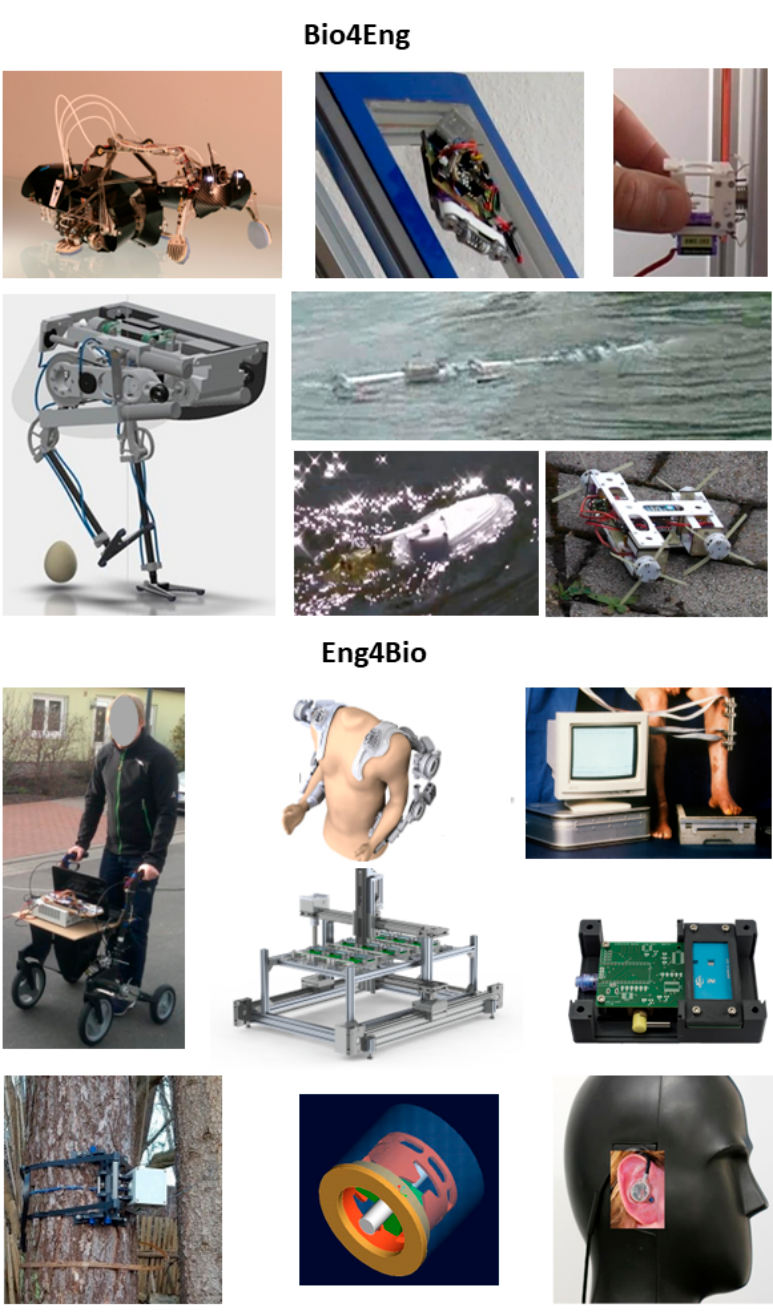
Figure 2. Examples of biomechatronic development. In reading order, please find for Bio4Eng the climbing robot RatNic (coop. Tetra GmbH lmenau, granted by the German Ministery of Education and Research BMBF) [60]; the window-cleaning robot MatBo t; the adhesive gripper TaCare ; the bird-like robot eNandu (coop. FSU Jena, Gentle Robotics); the swimming robots CSnake and Urmele ; the small wheg robot T-Whex . For Eng4Bio: the walker eRolli ; the modular exoskeleton Leviaktor (coop. FSU Jena, HS Aalen, Gottinger, BM innovations, LSK, granted by German Ministery of Education and Research BMBF), the figure is provided by Gottinger; fixateur externe instrument for measurement of fragment motions in DoF 6 (coop. RU Bochum) [61]; the system view and module of the System for Automated Cell Cultivation and Analysis ( SACCA ; granted by the Carl-Zeiss Stiftung); a dendrometer; a sensor for gripping forces DoF 6, 20 × 25 mm [62]; and a Personalized Miniaturized Dosimeter ( PMD ; granted by BGN Mannheim Erfurt) [63].